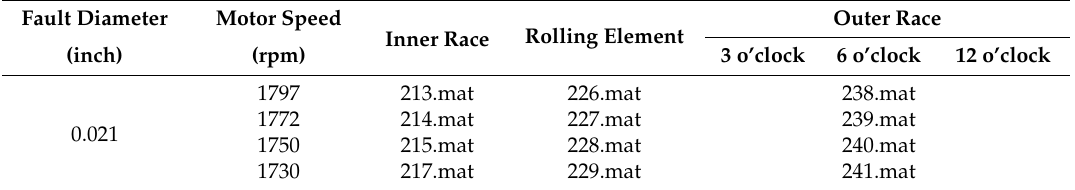
Table 1. Experiment parameters of each fault mode under different working